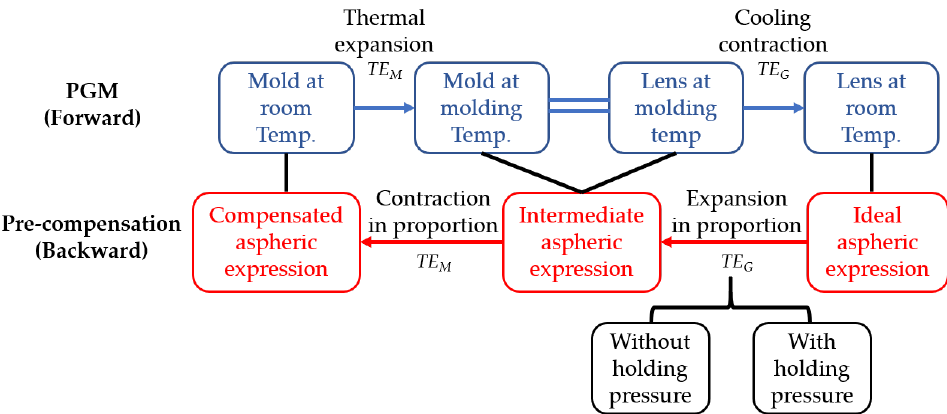
Figure 5. Micromachines 2020 , 11 , x